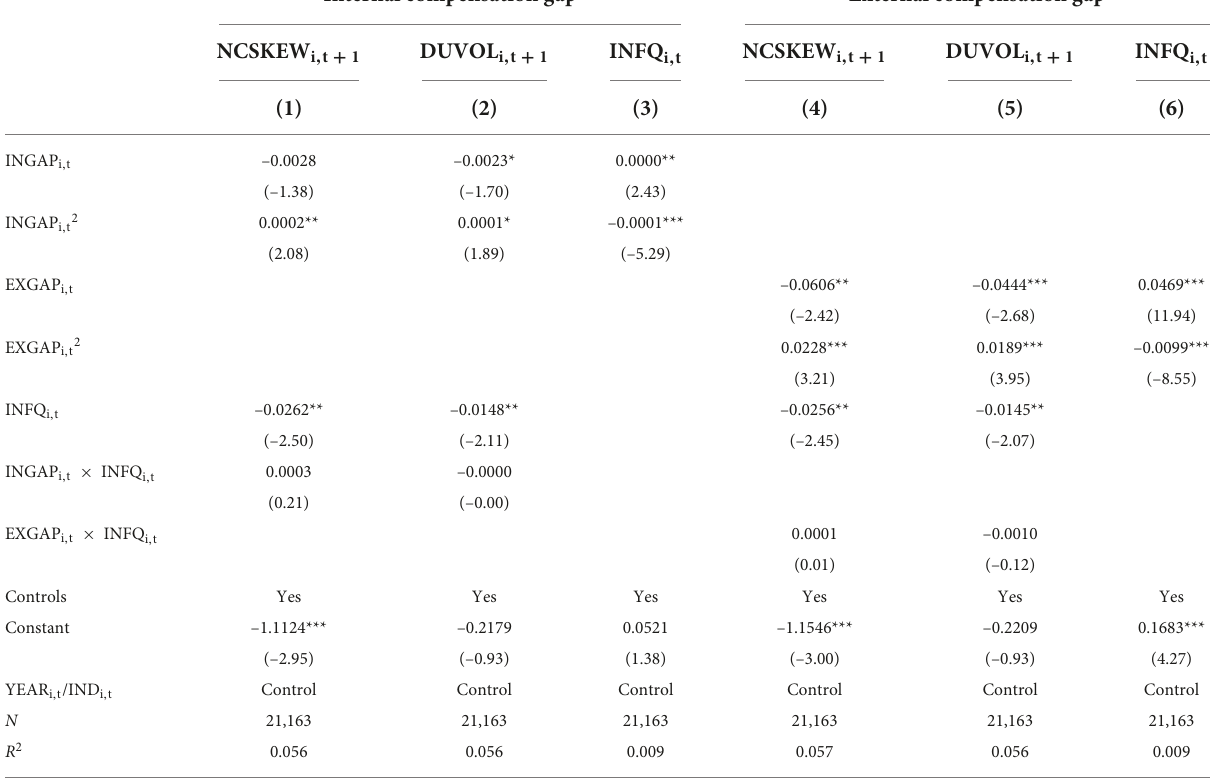
TABLE 8 Mediation effect of information disclosure